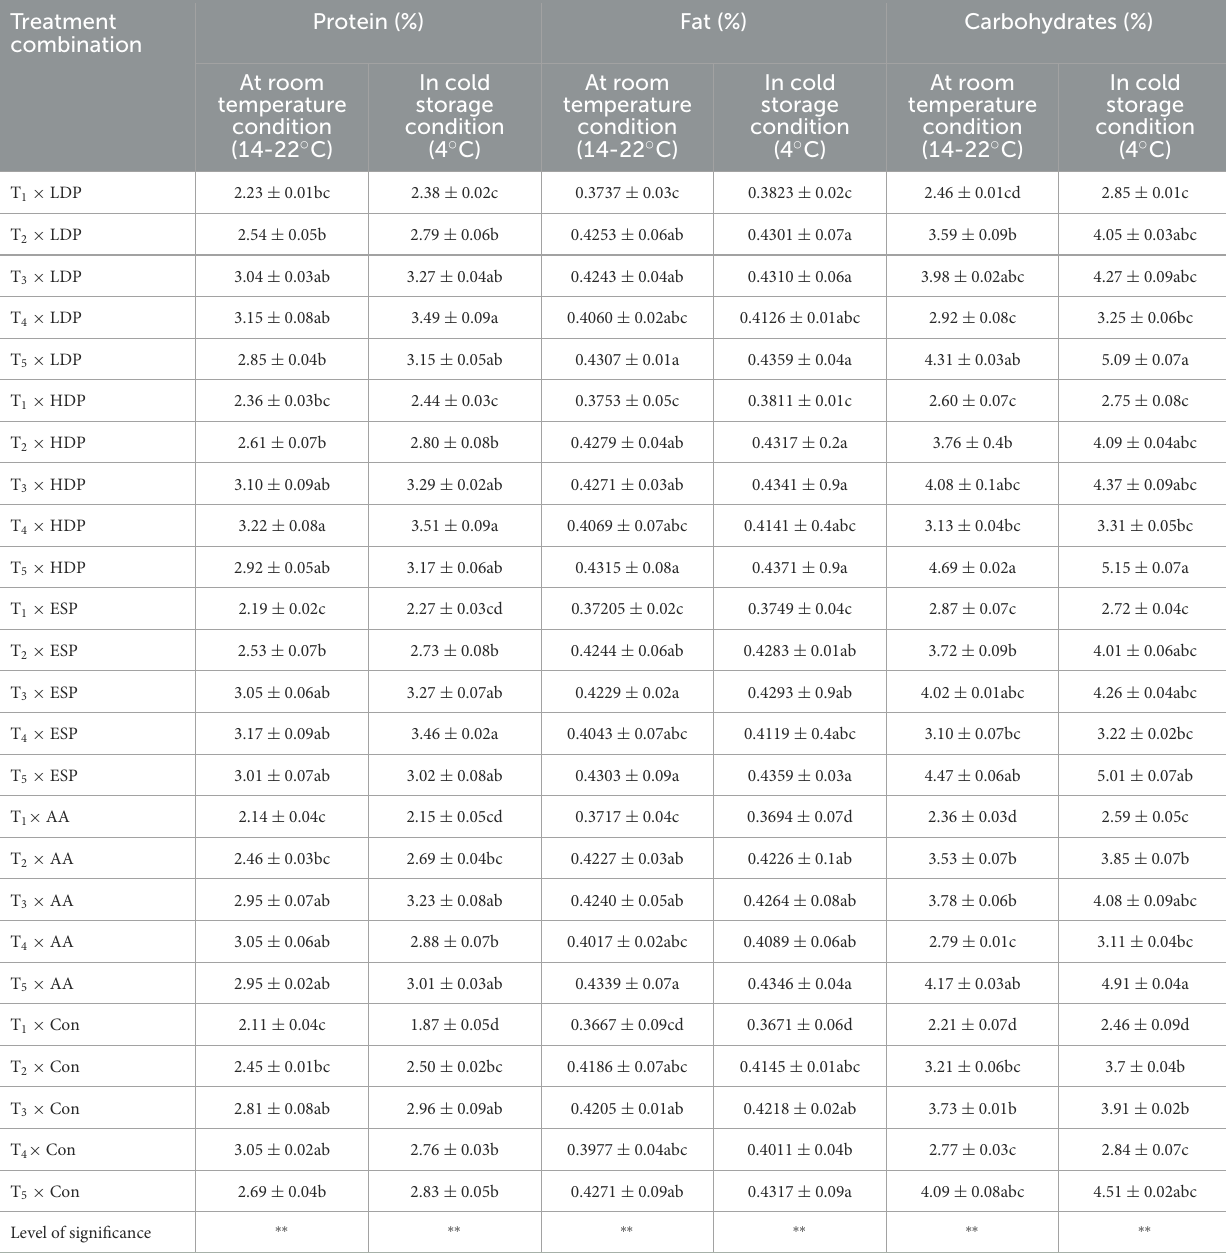
TABLE 6 Effects of pre-harvest foliar application of mineral nutrient sources and post-harvest packaging and chemical treatments on nutrient contents broccoli heads under different storage temperatures at the maximum shelf-life stage. Treatment